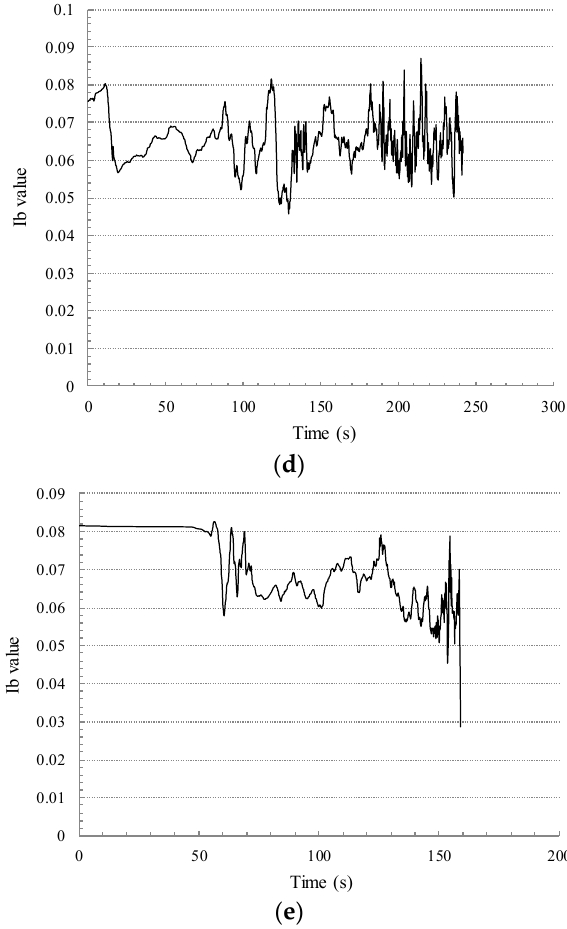
Figure 10. Ib-value curves of corroded RC beams: ( a ) Uncorroded RC beam; ( b ) 10% corroded RC beam; ( c ) 20% corroded RC beam; ( d ) 30% corroded RC beam; ( e ) 40% corroded RC beam. Table 3. Maximum and minimum values of the improved b (Ib)-value